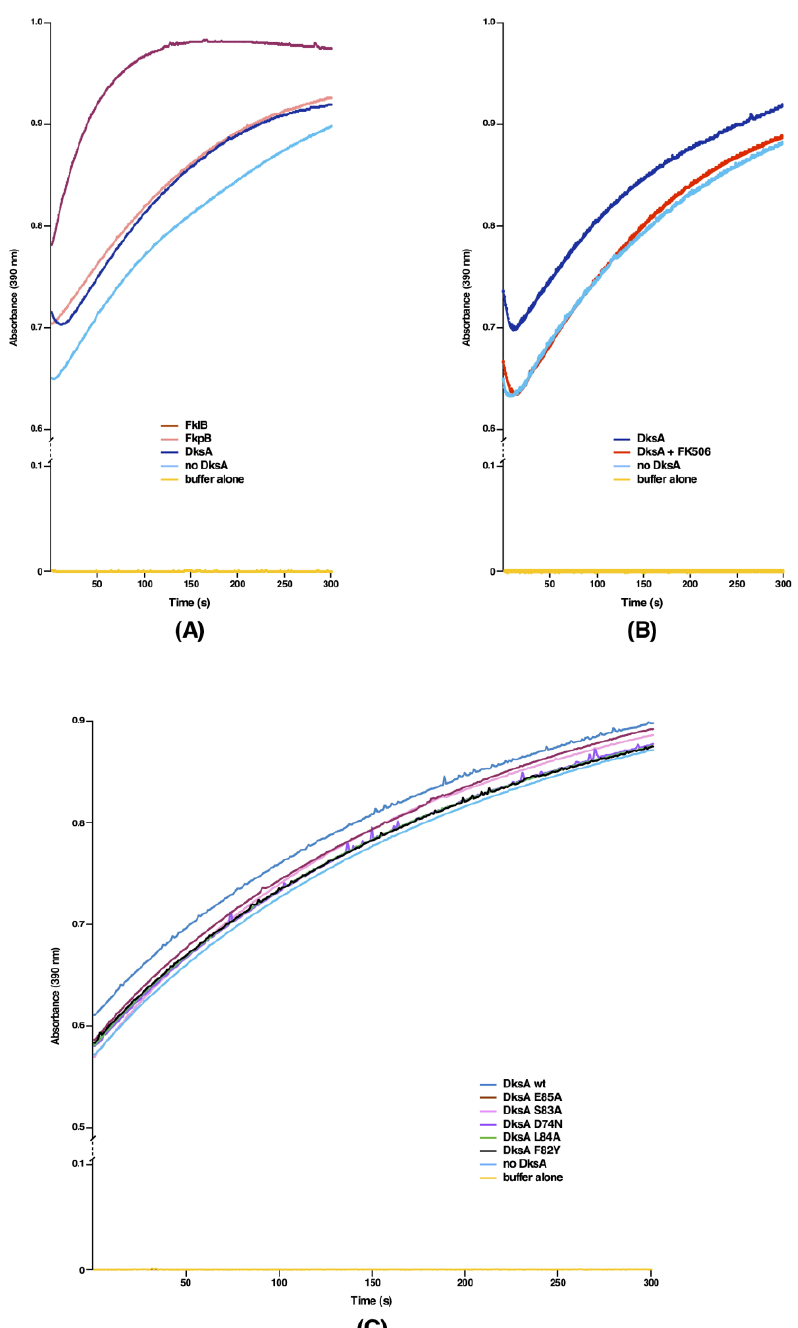
Figure 6. The RNA polymerase-binding protein DksA exhibits a PPIase activity that is comparable to that of FkpB and is inhibited by FK506. The PPIase activity was measured in the chymotrypsin-coupled assay using N -Suc-Ala-Ala- cis -Pro-Phe- p -nitroanilide as the substrate. ( A ) The comparative PPIase activity of FkpB, FklB and DksA proteins. ( B ) DksA was incubated with a two-fold molar excess of FK506 for 5 min at 10 ◦ C prior to the PPIase activity measurement. The PPIase activity of DksA in the presence or absence of FK506, along with uncatalyzed reaction are plotted. ( C ) Measurement of PPIase activity of wild-type DksA and its variants. Proteins were used at a concentration of 5 µ M each. multicopy suppressors of the growth defect of 6 ppi bacteria (Figure 3). These results allow us to conclude that there exists an overlap in the function of major chaperones and cytoplasmic PPIs in E. coli and both pathways are dedicated to ensure correct folding of proteins in the cell, consistent with the accumulation of several common proteins that aggregate in 6 ppi and Δ( dnaK dnaJ tig ) derivatives